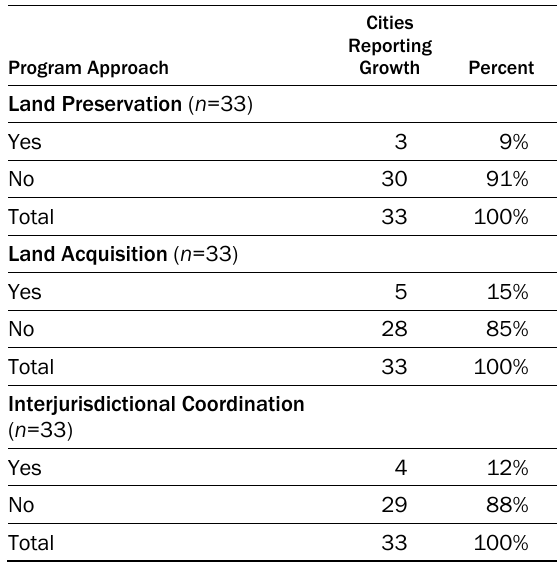
Table 7. Programs for Preservation and